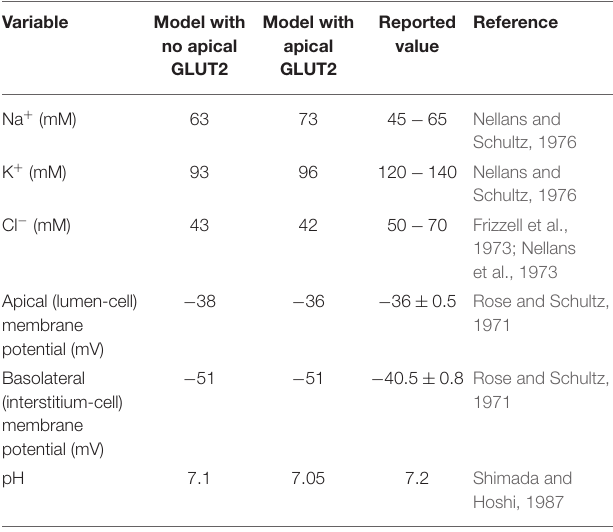
TABLE 3 | Steady state model predictions with and without apical GLUT2 with luminal glucose = 50 mM compared to literature values. Variable